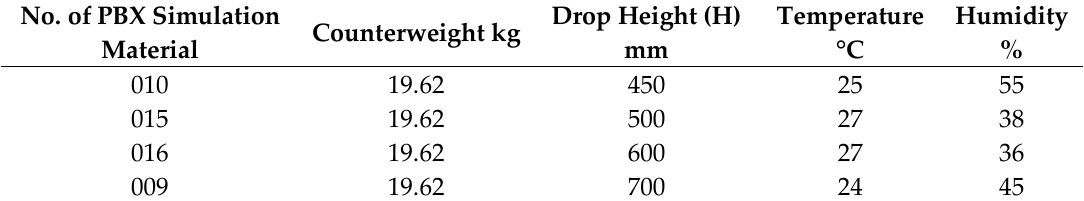
Table 2. Drop impact parameters of the test